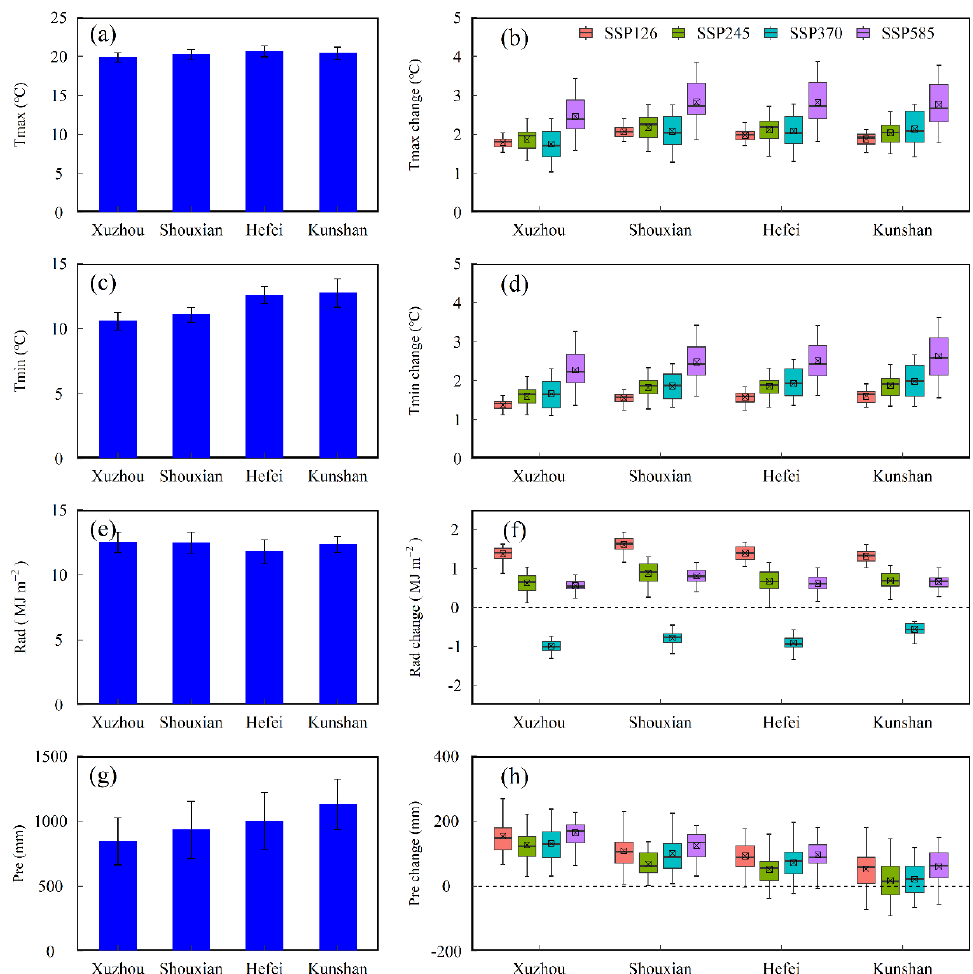
Figure 3. Annual mean maximum ( Tmax ) ( a ) and minimum temperature ( Tmin ) ( c ), solar radiation ( Rad ) ( e ) and precipitation ( Pre ) ( g ) for the baseline period (1981 – 2010) and projected changes in annual mean Tmax ( b ), Tmin ( d ), Rad ( f ) and Pre ( h ) in the 2050s (2041 – 2070) period under SSP126, SSP245, SSP370, and SSP585 compared to the baseline period across the 22 CMIP6 GCMs in the four agro-meteorological stations. The black lines and crosshairs within each box indicate the multi-model median and mean, respectively. Box boundaries indicate the 25th and 75th percentiles across 22 GCMs, whiskers below and above the box indicate the 10th and 90th percentiles. Same as below figures.